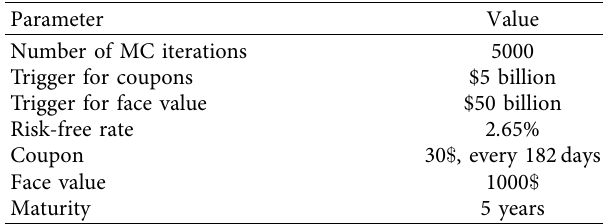
Table 2: Other parameters used for Greeks calculation.